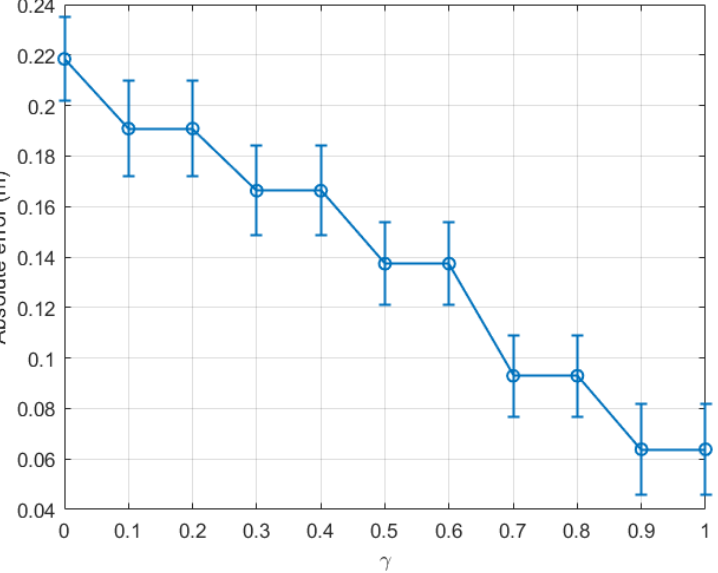
Figure 7. Indoor walking (dataset 2): absolute error of the last time window ( tw 11 ) with respect to γ ∈ [ 0,1 ] .